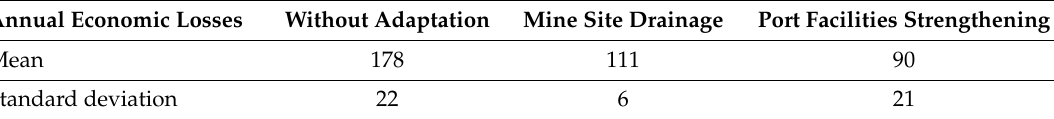
Table 10. Results of the hybrid CLGN model for CLIRMI mine (economic losses in 1000